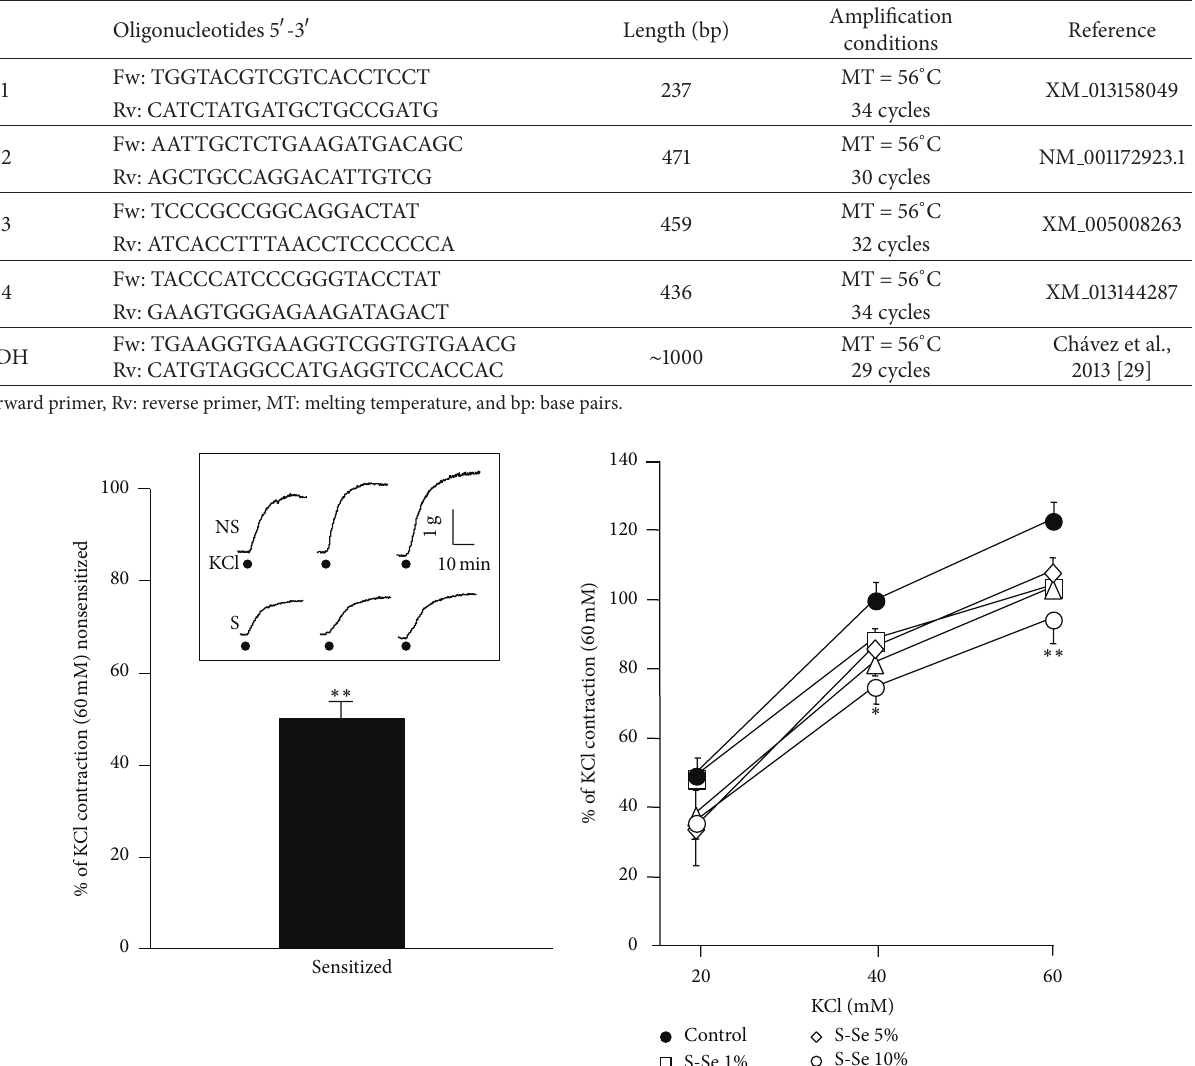
Table 1: Sequence of primers and PCR conditions for the different subunits of L-VDCC.